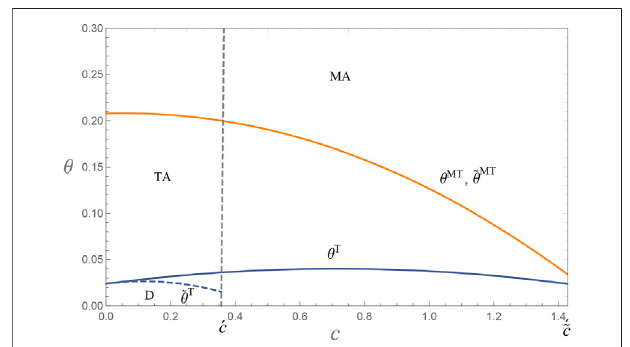
FIGURE 4 | Optimal channel strategy in equal and unequal pricing. ( a (cid:1) 1 , b (cid:1) 0 . 4